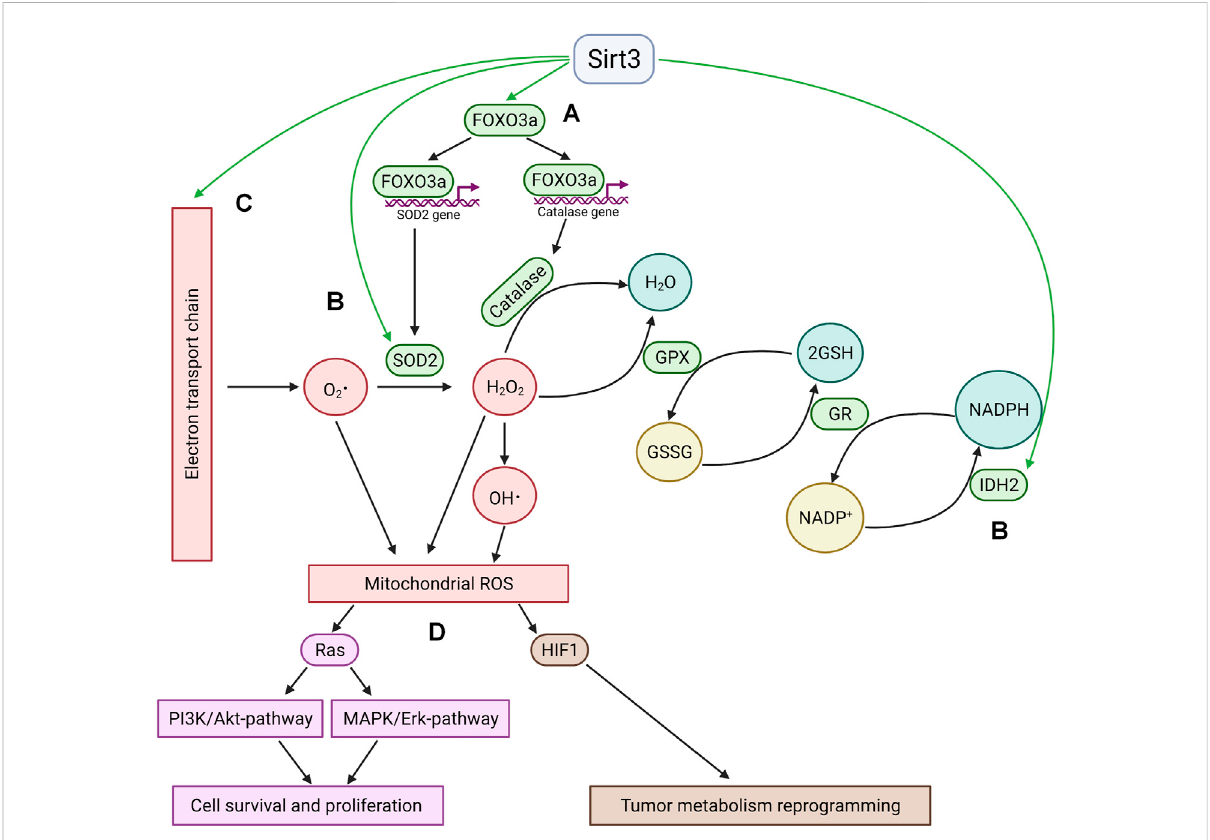
FIGURE 1 Sirtuin 3 and ROS. (A) ; Sirt3 stimulates the expression of key antioxidant enzymes MnSOD2 and catalase via deacetylation of FOXO3a. DeacetylationoccurseitherinthemitochondriawithsubsequenttranslocationofFOXO3aintothenucleusorbymeansofnuclearfractionofSirt3in thenucleus. (B) ;Sirt3directly deacetylates andactivates mitochondrialenzymesimplicated inROS quenching(IDH2and SOD2). (C) ;Sirt3decreases electron leakage from mitochondrial electron transport chain by deacetylation of its complexes. (D) ; The antioxidant activity of Sirt3 leads